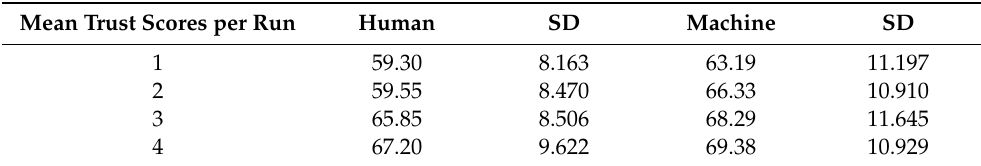
Figure 4. Mean scores of trust per condition through journeys. Table 1. Mean trust scores as measured by [75] and related standard deviation for both human and machine driving styles. 291